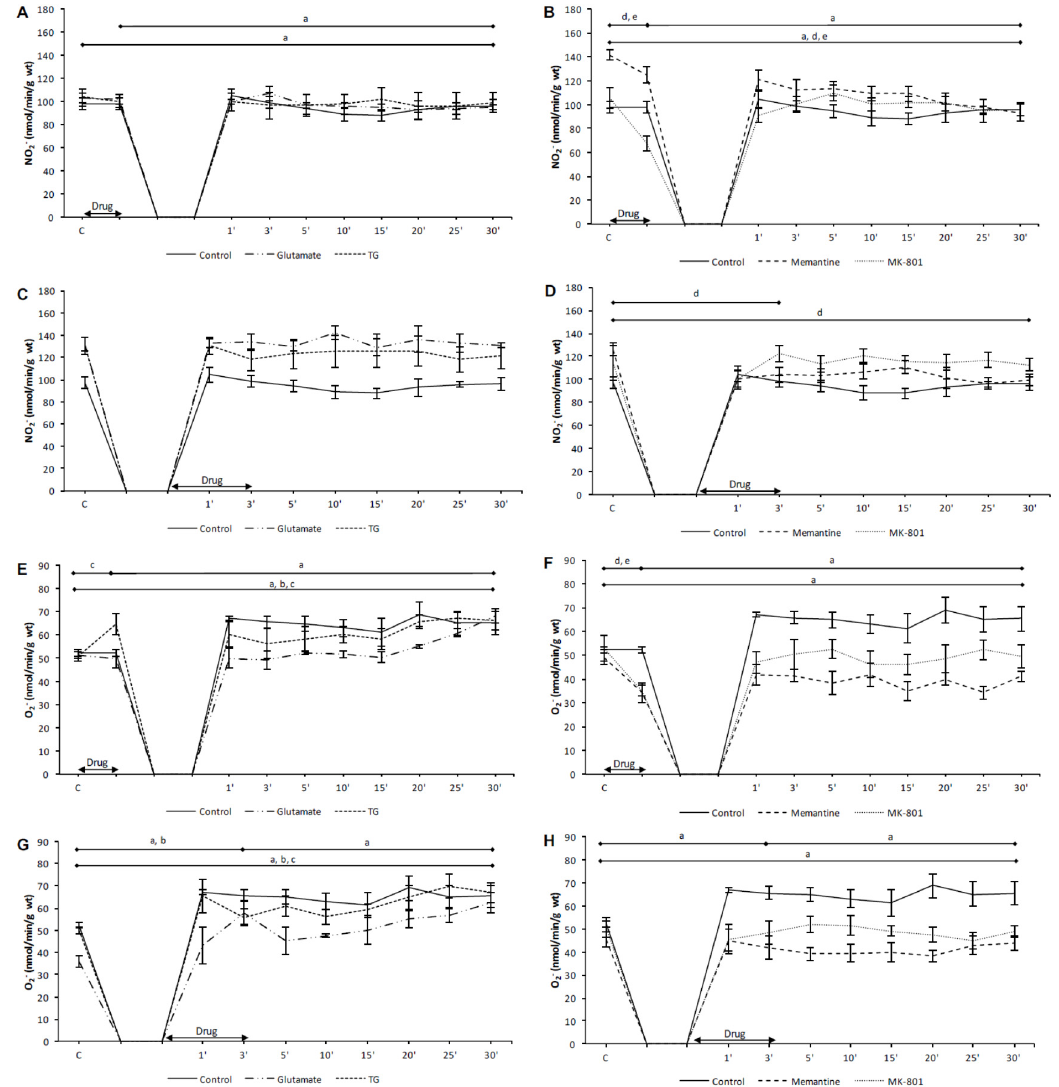
Figure 5. The e ff ects of cardiac NMDAR modulation in preC and postC on NO 2 − Figure 5. The effects of cardiac NMDAR modulation in preC and postC on NO 2 − and O 2 − . ( A , E ) preconditioned with glutamate and TG; ( B , F ) preconditioned with memantine and MK-801; ( C , G ) postconditioned with glutamate and TG; ( D , H ) postconditioned with memantine and MK-801.